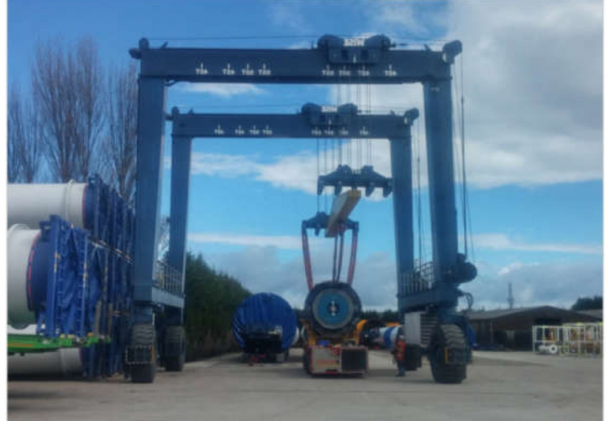
Figure 7. Configuration of the experiments to validate the proposed regression model: Crane, trailer and load.